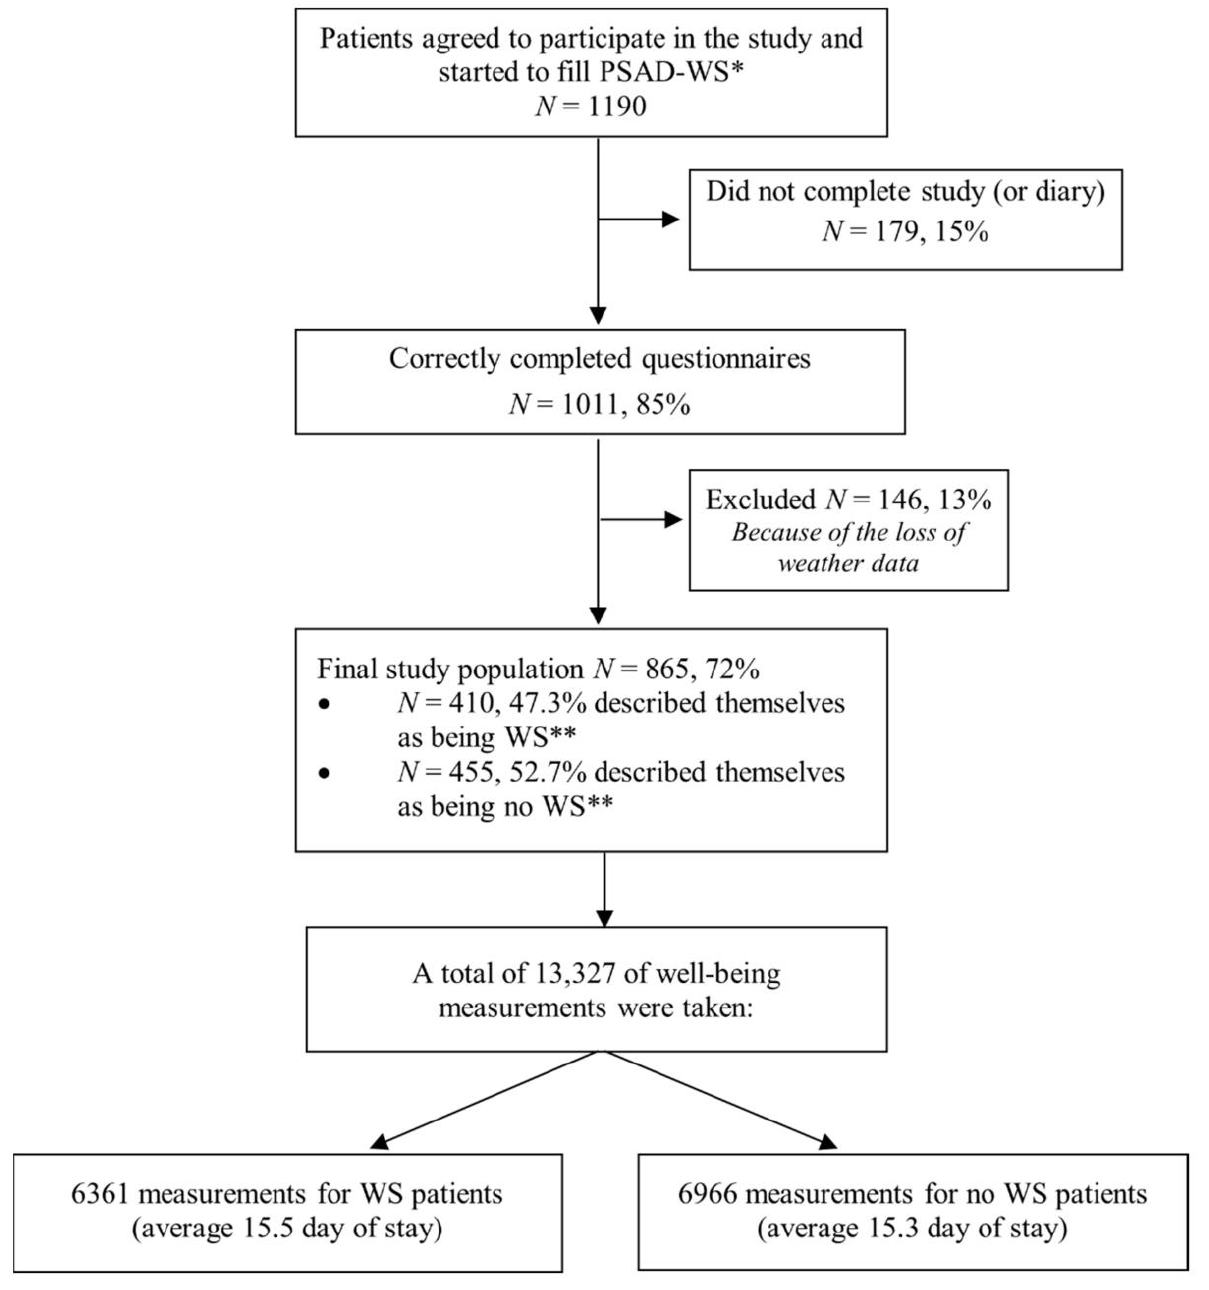
Figure 1. Flowchart of the study. * PSAD-WS, Palanga self-assessment diary for weather sensitivity; ** WS, weather